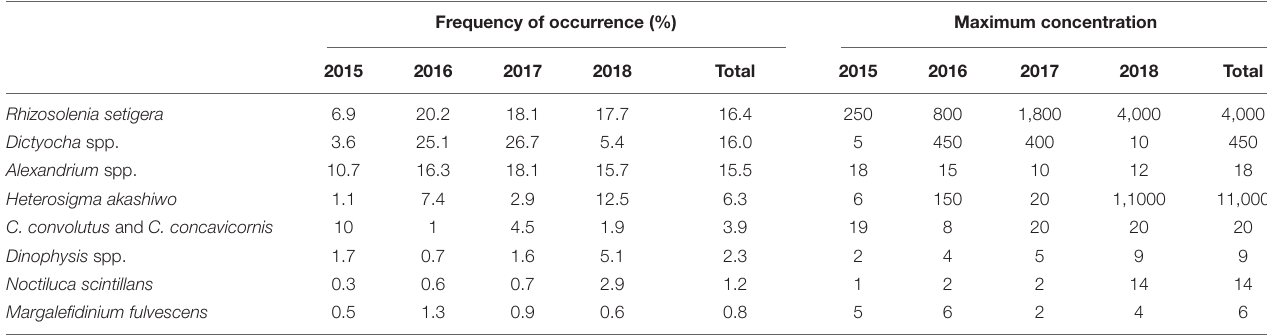
TABLE 2 | Frequency of occurrence (percent of samples containing HA) and maximum concentration (cells mL − 1 ) recorded in surface samples in different years. Frequency of occurrence (%) Maximum